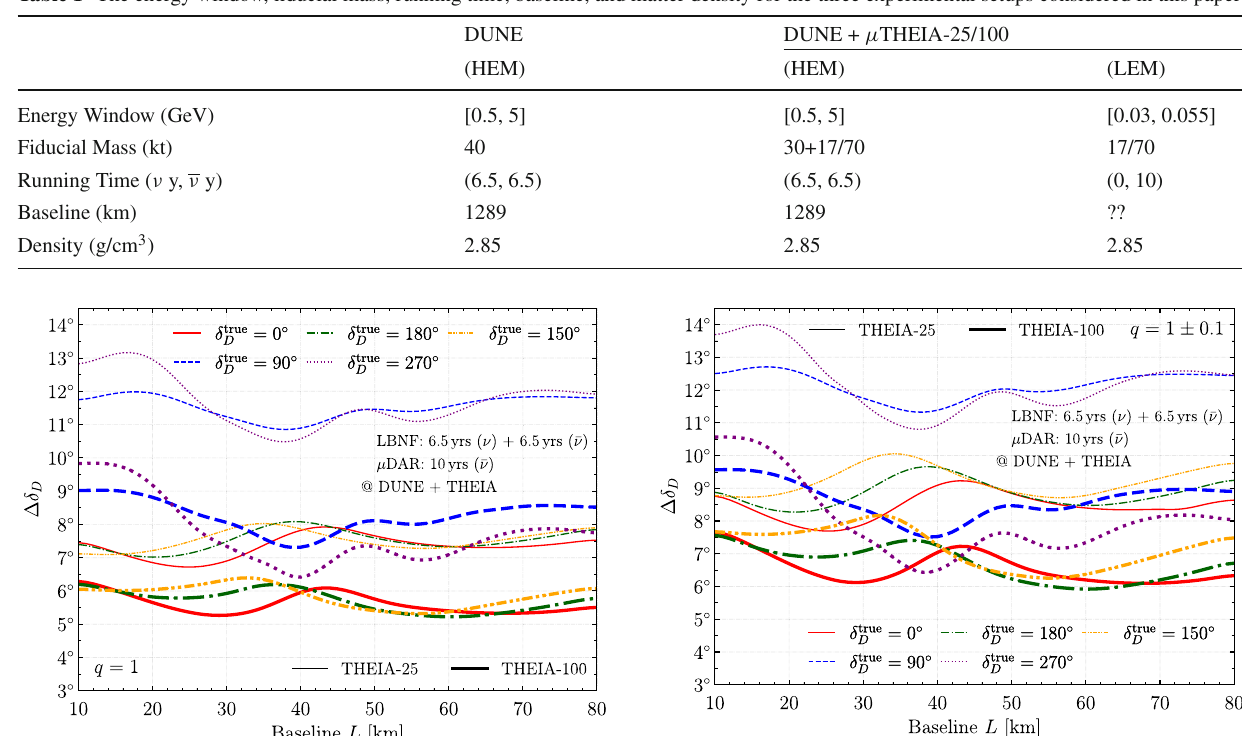
Table 1 The energy window, fiducial mass, running time, baseline, and matter density for the three experimental setups considered in this paper